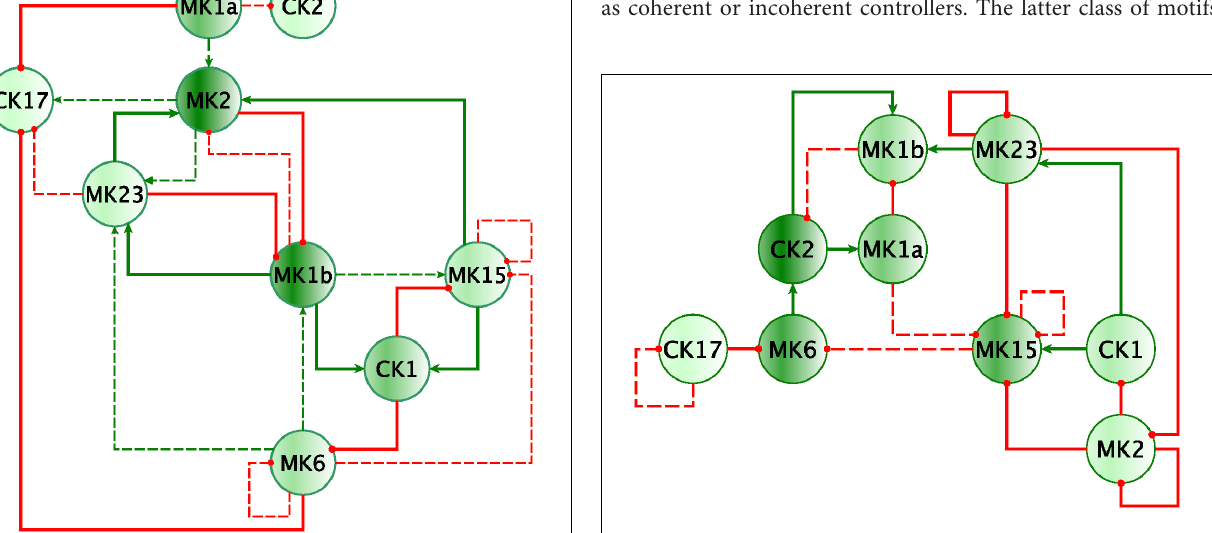
FIGURE 2 | Mechanistically informed GWI regulatory motif. Regulatory interactions extracted from documented prior knowledge that are uniquely represented in the experimental data in GWI during recovery from maximum exercise. Solid lines represent interactions uniquely expressed in HC while dashed lines show interactions shared with GWI. Green arrows indicate a stimulatory action while red “T” terminators indicate suppressive actions.